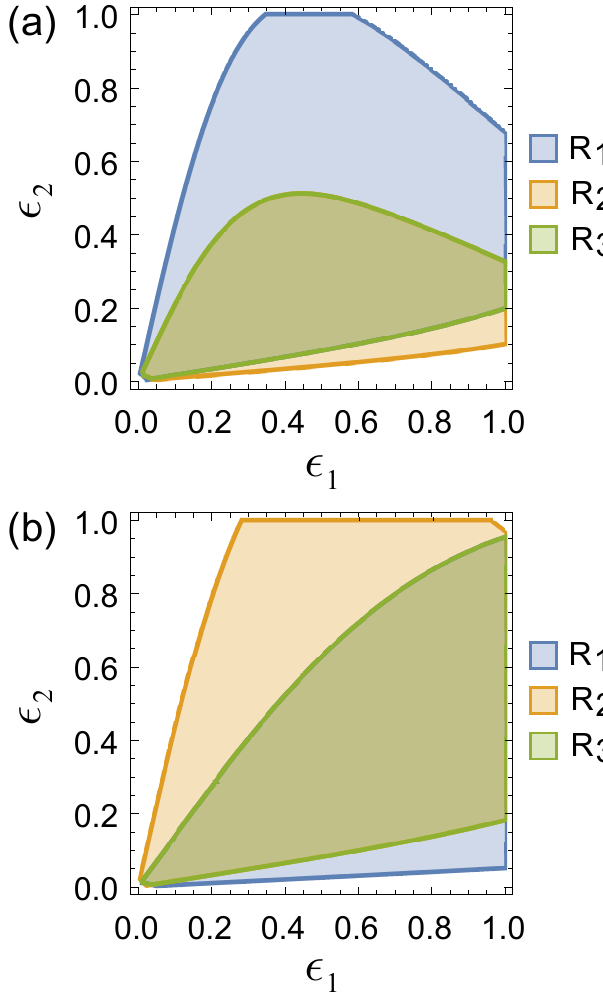
Figure 9: The parameter space ( ϵ 1 , ϵ 2 ) characterizing local filtering operations is considered in both subfigures. Shaded regions characterize suitable local filtering operations (used in the modified QKD protocol) for some specific states from the class given by Eq. (29). Consider two F 3 unsteerable states specified by ( q , α ) = (0 . 6 , 0 . 7) and ( q , α ) = (0 . 5 , 0 . 4) . In subfigure (a), any point in the region R 1 ∪ R 2 gives suitable local filters for the first state, whereas that for the second state is given by any point from the region R 2 ∪ R 3 . Next consider two steerable states: ( q , α ) = (0 . 9 , 0 . 26) and ( q , α ) = (0 . 68 , 0 . 7) . In subfigure (b), suitable local filters for these two steerable states are given by any point from region R 1 ∪ R 2 and R 2 ∪ R 3 , respectively.